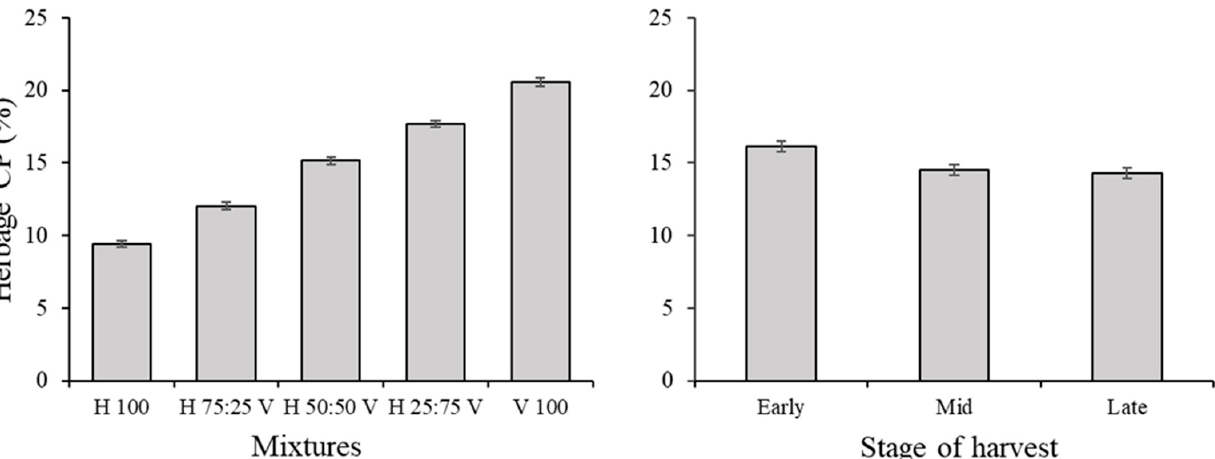
Figure 2. Herbage CP concentration as affected by MX ( left ) and SH ( right ) mean effect. Values are LSmeans across all treatments along with standard error estimate of the LSmeans since the design was unbalanced between the faba bean crop ( n = 9) compared to the mixtures and the barley crops ( n = 18).